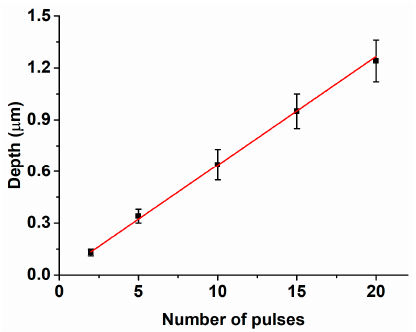
Figure 2. Effect of pulse number on machined depth of micro-craters.